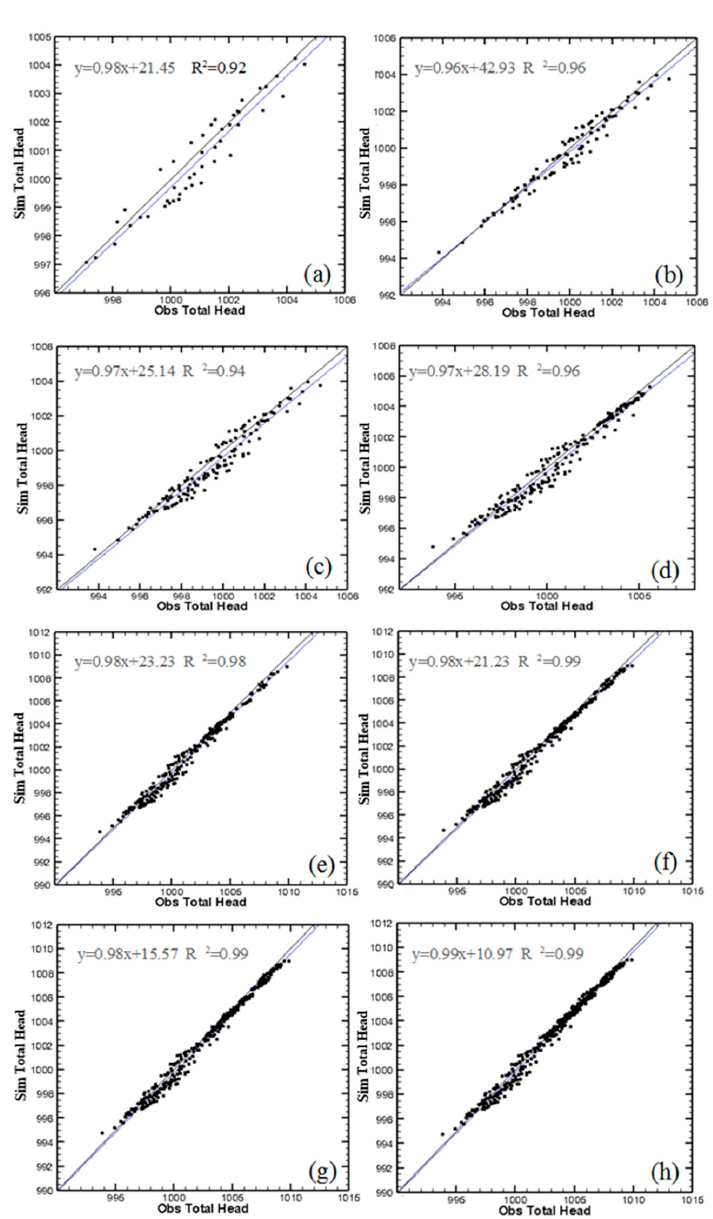
Figure 2. Scatter plots of the fitting curves for the estimated and actual head values with the number of pumping cycles varying from 1 to 8: ( a ) 1 pumping test, ( b ) 2 pumping tests, ( c ) 3 pumping tests, ( d ) 4 pumping tests, ( e ) 5 pumping tests, ( f ) 6 pumping tests, ( g ) 7 pumping tests, and ( h ) 8 pumping tests. Centered. The units of axis are [mm].